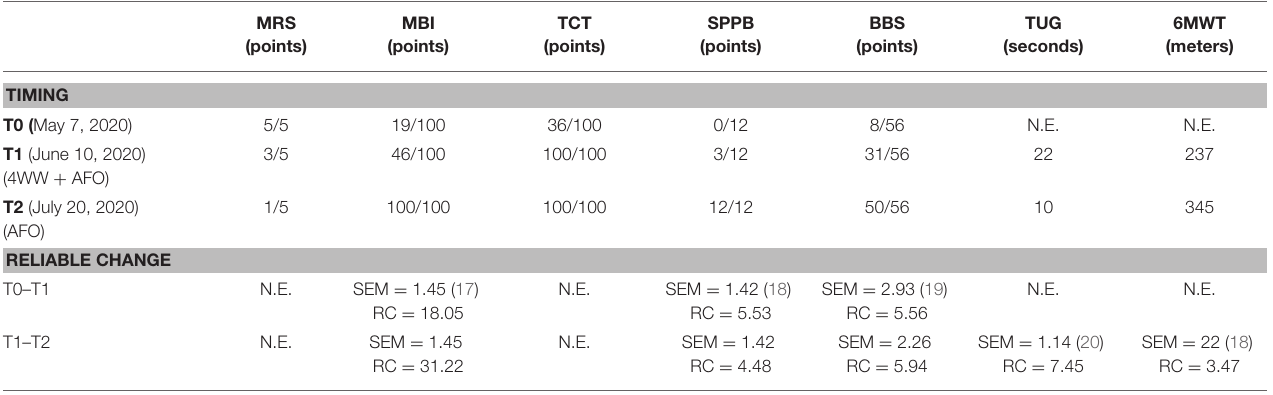
TABLE 2 | Results of motor and functional